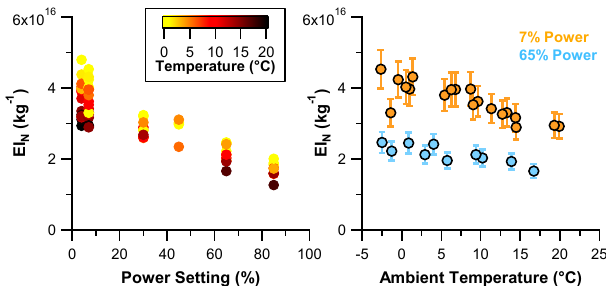
Fig. 8. JP-8 EI N measured at 30m from the exhaust plane on engine #2 colored by the ambient temperature (left) and EI N as a function of temperature at 7 and 65% power (right). Data are solely from the #2 engine. For clarity, measurement uncertainties for EI N (12%) are not shown on the left. EI N at 7 and 65% are plotted relative to the interpolated EI N at 15 ◦ C (the ICAO standard temperature) in Fig.